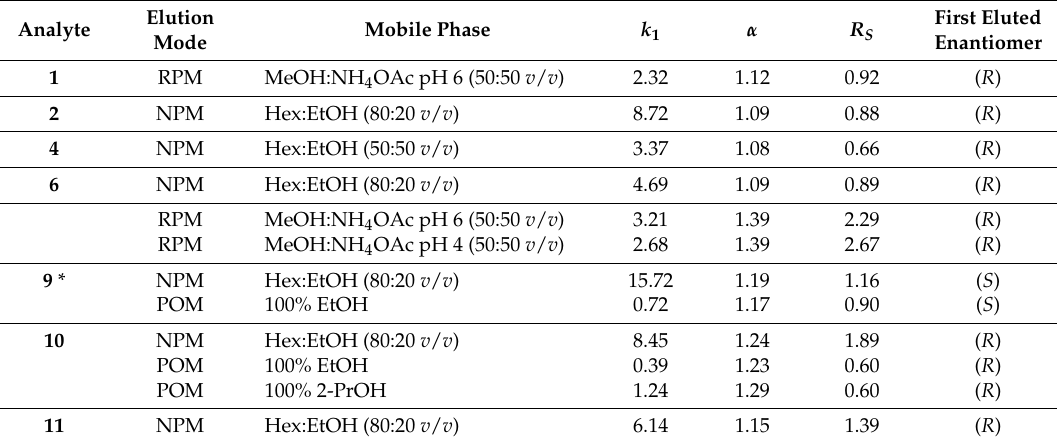
Table 3. Chromatographic data, retention factor of first eluted enantiomer ( k 1 ), separation factor ( α ), resolution ( R S ), and elution order, for the chiral xanthonic analytes on the Chirobiotic TM V column, under multimodal chromatographic conditions.